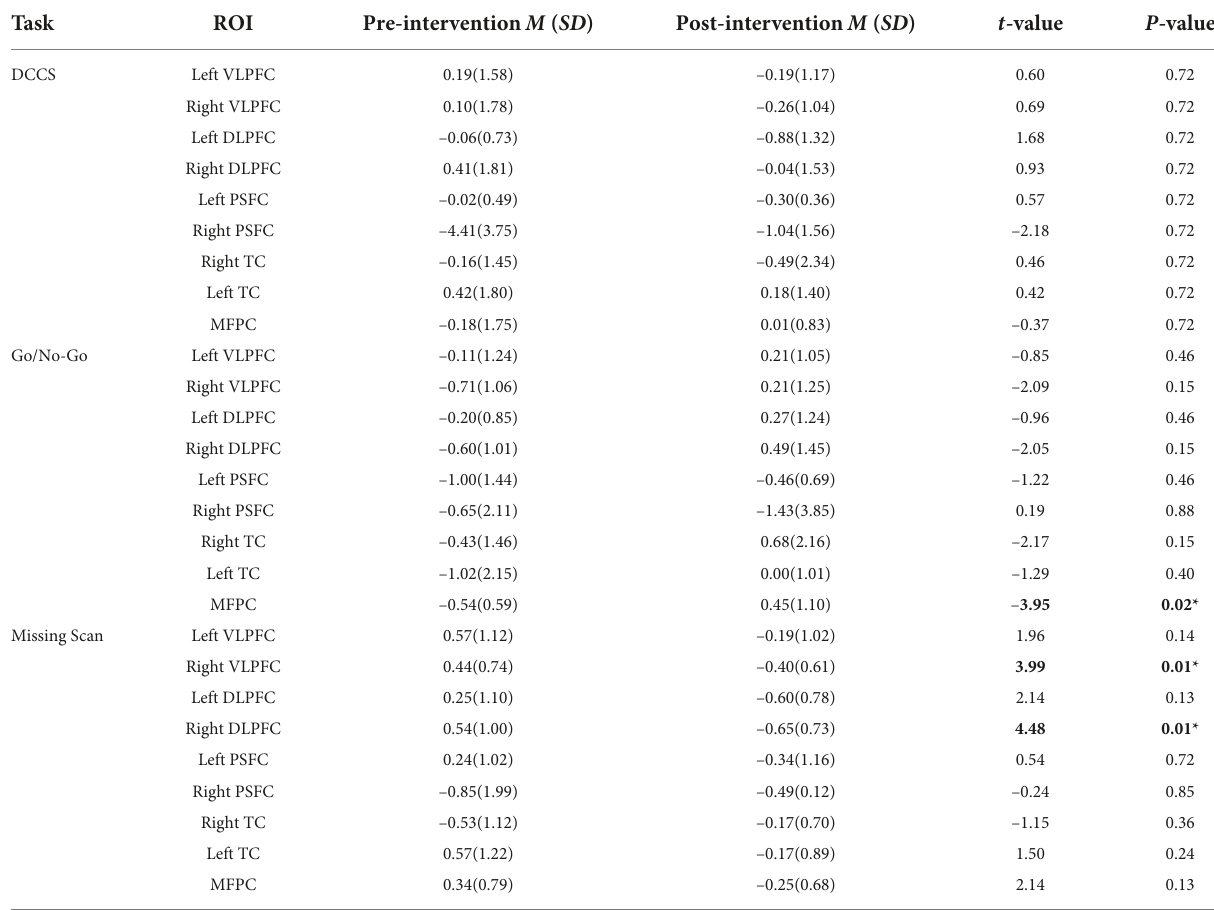
TABLE 5 Comparison of increases in HbR before and after the intervention for girls ( N =